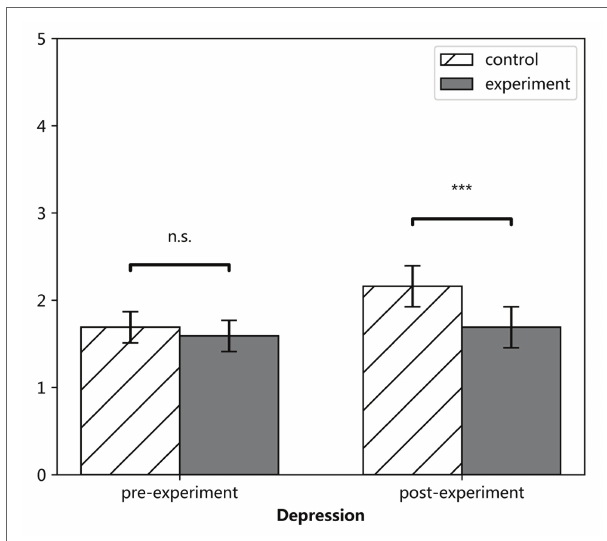
FIGURE 1 | Levels of depression for groups before and after the experiment. *** p <